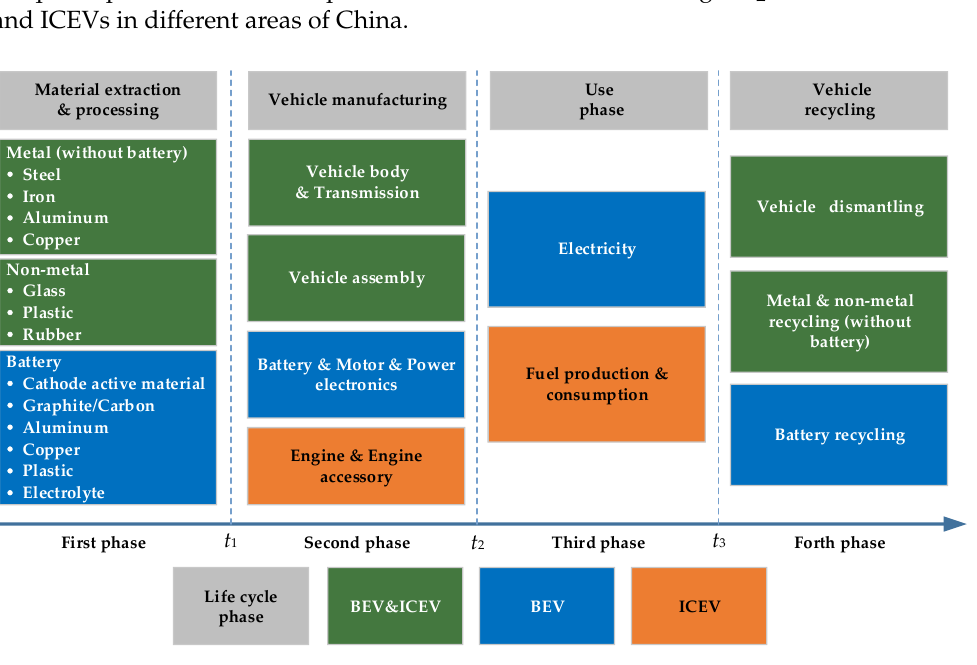
Figure 3. Framework of carbon emission comparison between ICEVs and BEVs in four phases of LCA.